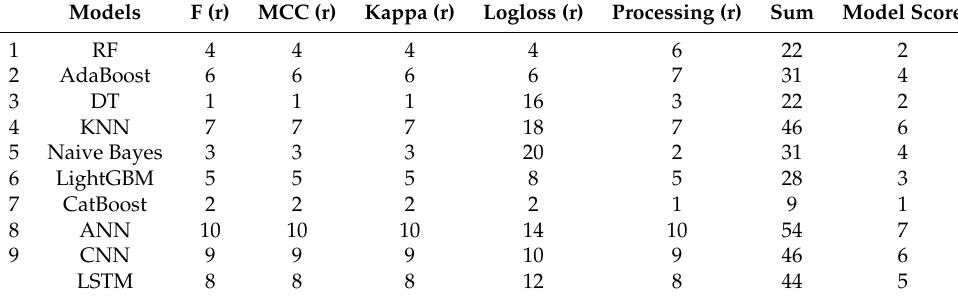
Table 11. Model performance for